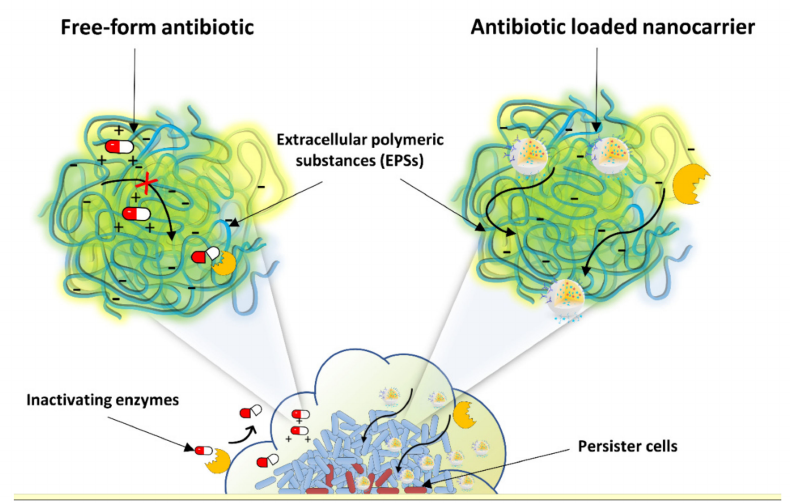
Figure 2. Schematic illustrates the protection mechanisms of antibiotic-loaded nanocarriers from deleterious interactions with the extracellular polymeric substances (EPS) or enzymatic inactivation in bacterial